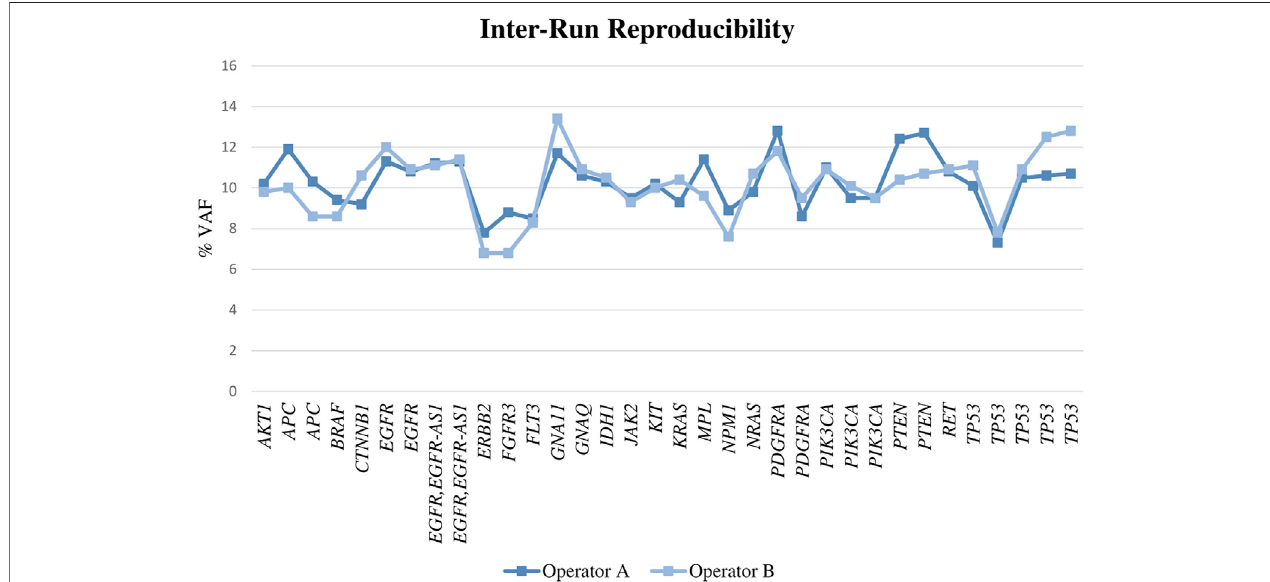
FIGURE 3 | VAF obtained for the assessed genes performing the libraries by two different operators.